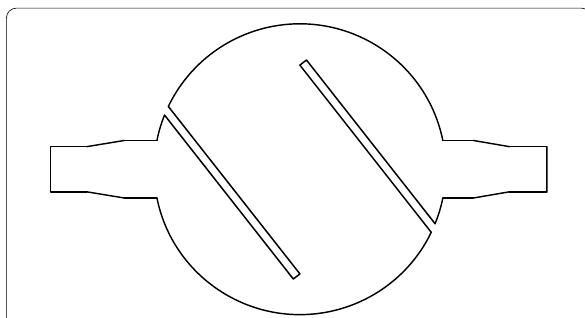
Figure 17 Expansion chamber pulsation attenuator with baffle plates